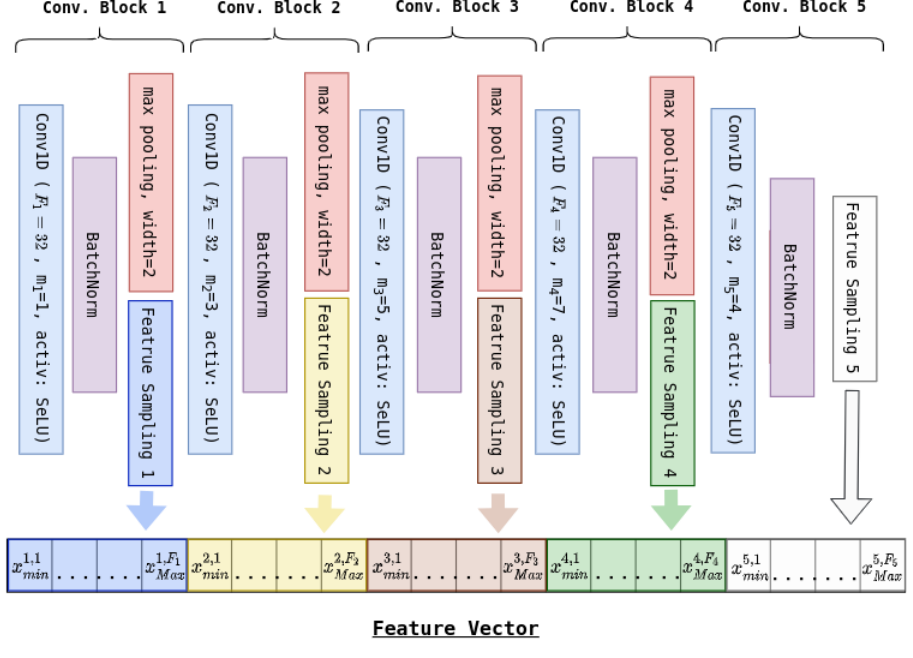
Figure 2. Architecture of a convolution group. For the convolution operation (in blue), F l and m l refer to the number of convolution filters ( F l ) and their width along the temporal dimension ( m l ) according to the conv. block to which they belong ( l ), and activ. refers to the activation function. The purple rectangle is there to illustrate the batch normalization operation applied to the convolutions’ output. From this normalized output, max pooling is applied, resulting in a new time series X l from which elements of the feature vector are sampled and serving as the next block’s